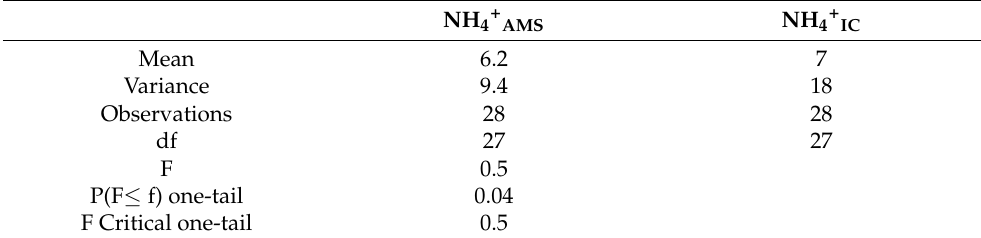
Table 2. Result of F-test between NH 4+ (AMS) and NH 4+ (IC). Mean 6.2 Variance